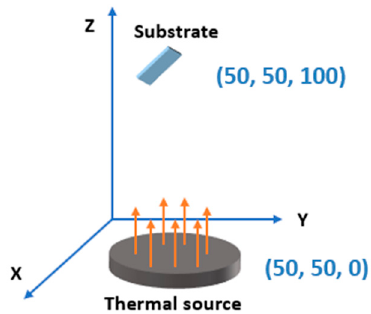
Figure 1. The geometry schematic of the OAD method in NASCAM.